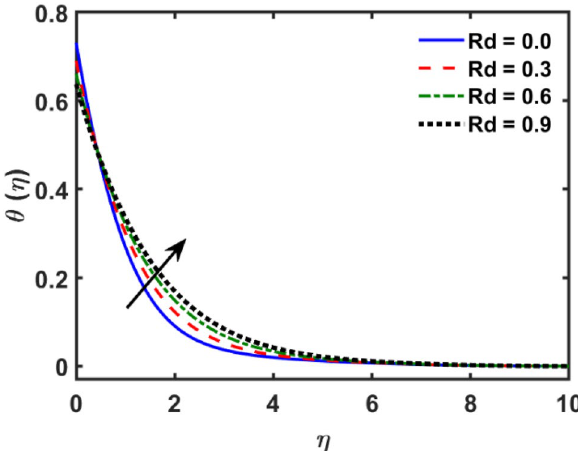
Figure 10. Variation of Rd on θ(η) .